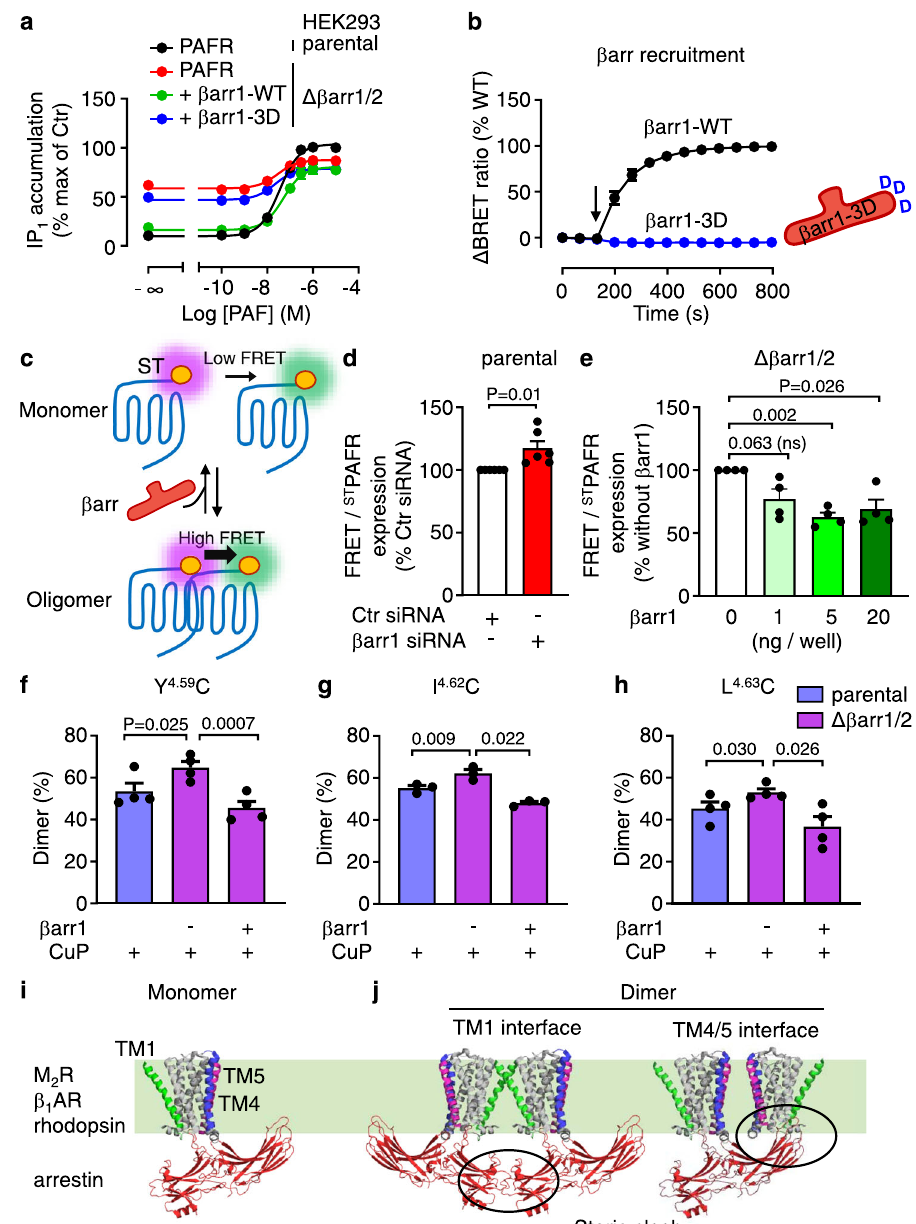
Fig. 8 | β -arrestin impairs both constitutive activity and PAFR oligomers. a IP 1 mediatedbyPAFRuponstimulationwithPAFinparental(Ctr)or Δβ arr1/2HEK-293 cells. Dataare mean±SEM from n =3independent experiments and normalized to Ctr. b Kinetics of the BRET signal between PAFR-Venus and β arr1-Rluc after the injectionofPAF(1 μ M,arrow)fortheWTandtheindicated β arr1-3Dmutant(L335D, L338D, S340D). Data are mean±SEM from n =3 independent experiments and normalizedtoWT. c SchemeillustratingtheequilibriumbetweenSNAP(ST)-tagged PAFR monomers and oligomers at the cell surface that is modulated by β arr. Cell surfaceoligomersaremeasuredbythehighTR-FRETsignalbetweentheN-terminal SNAP-tag labeled with a pair of non-cell permeant fl uorophores compatible with FRET. d TR-FRET signal for the SNAP-tagged PAFR WT ( ST PAFR) corrected by the amount of ST PAFR at the cell surface measured by the emission of non-cell per- meantST-Lumi4-Tb,inparentalHEK-293cellstransfectedwiththeindicatedsiRNA. Data are mean±SEM from n =6 independent experiments and normalized to control(Ctr)siRNA. e TR-FRETsignalmeasurementwith Δβ arr1/2HEK-293cellsco-